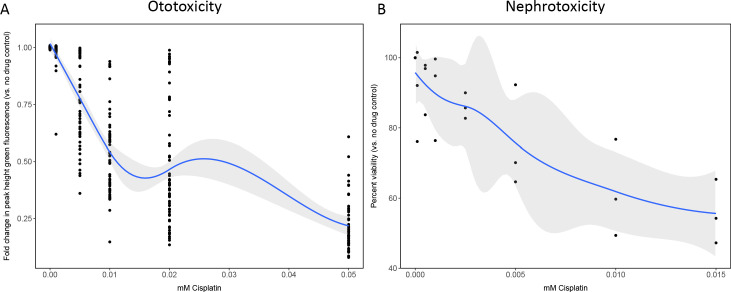
Dose–response curves demonstrate decreasing neuromast integrity and human proximal tubule cell viability with increasing doses of cisplatin.(A) Groups of 50 casper zebrafish larvae were treated with increasing doses of cisplatin, by addition to the E3 media, at 72 hr post-fertilization (hpf). Two days later, larvae were stained with 2 µM YO-PRO1, then were subjected to Biosorter-mediated fluorescence profiling. Peak Height (PH) of green fluorescence is displayed, relative to untreated controls. Each data point represents an individual larva. Dose–response relationship is represented by the blue line, calculated with a four-parameter log-logistic model, as described in a relevant study (Ritz et al., 2015). Modeling was done in R with a drc extension package. Grey-shaded area represents the 95% confidence interval (CI) of this line. (B) HK-2 human proximal tubule cells were treated with increasing concentrations of cisplatin for 24 hrs. Cells were rinsed, then an alamarBlue assay was performed as per the manufacturer’s instructions. Data are represented as % viability, in comparison with untreated cells. N=3, an average of at least two wells was measured per replicate. Dose response analysis performed as in A).